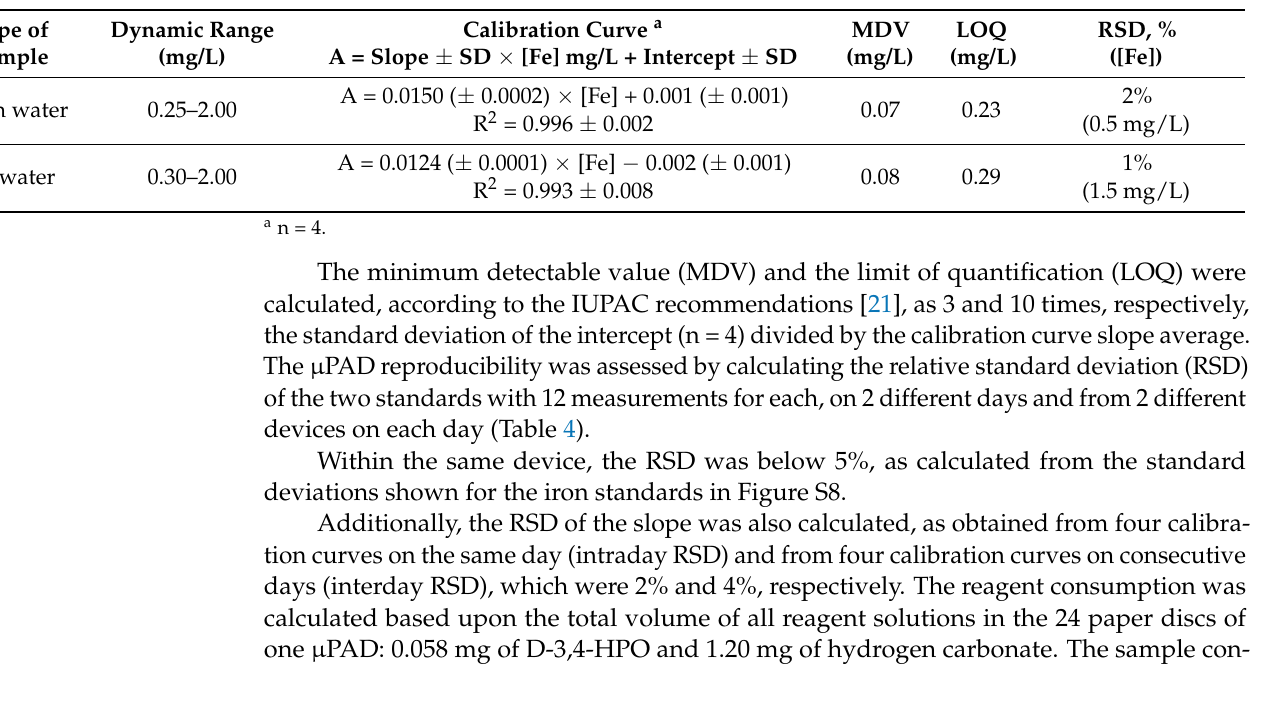
Table 4. Summary of the analytical features of the developed µ PAD for iron determination in water; SD, standard deviation; MDV, minimum detectable value; LOQ, limit of